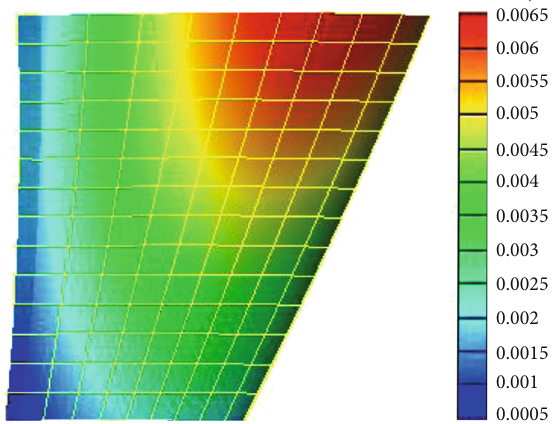
Figure 8: The thickness distribution of the upper skin (case 2).